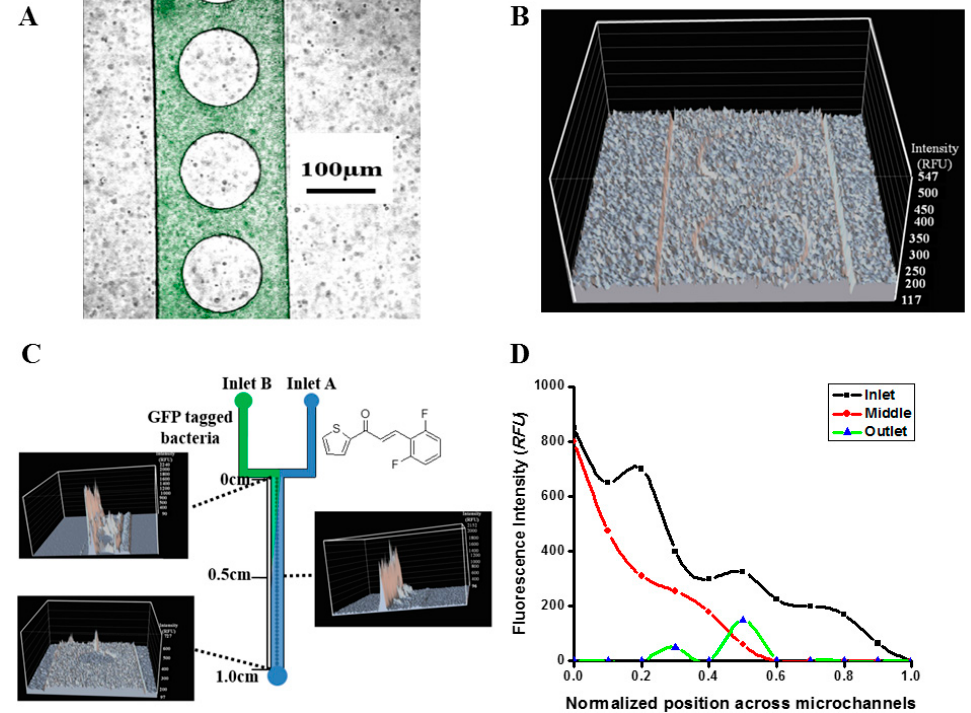
Figure 2. ( A ) Actual image of P. aeruginosa PAO1 inside microfluidic sensor without 1-TDPPO; ( B ) fluorescence intensity profile after P. aeruginosa PAO1 reacted with 1-TDPPO; ( C ) antimicrobial activity based on GFP-tagged fluorescence intensity (inlet A: 1-TDPPO; inlet B: P. aeruginosa PAO1); and ( D ) the fluorescent intensity (RFU) along with the normalized microfluidic channel position.